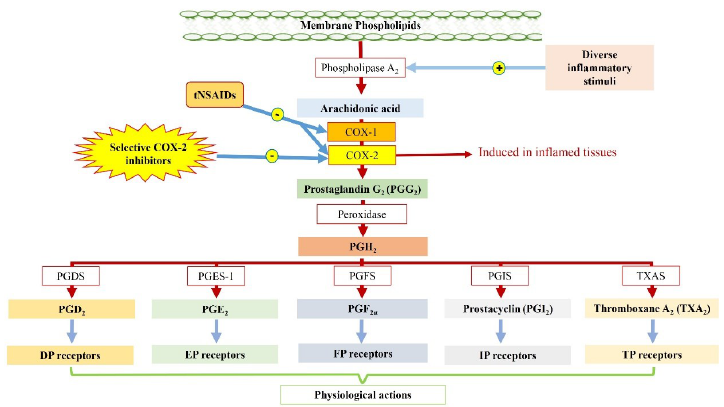
Figure 1. Biosynthesis of prostaglandins and associated compounds. For instance, arachidonic acid is liberated by Ca 2+ stimulation mediated by diverse inflammatory stimuli or phosphorylation of phospholipase A 2 from the membrane phospholipid. The cyclooxygenase enzymes (both COX-1 and COX-2) epoxygenate arachidonic acid into prostaglandin G2 (PGG 2 ), which is further converted into prostaglandin H 2 (PGH 2 ) with the help of peroxidase enzyme. Following this, PGH 2 undergoes conversion into prostaglandin (PG) analogues (i.e., PGD 2 , PGE 2 , PGF 2 α , and PGI 2 or prostacyclin) and thromboxane A 2 (TxA 2 ) by the help of isomerases and synthases, respectively. The formed PGs and associated compounds are capable of triggering a myriad of signalling events by activating their respective membrane receptors located at the site of production. The traditional non-steroidal anti-inflammatory drugs (tNSAIDs) inhibit cyclooxygenase enzyme non-selectively and prevent prostaglandin synthesis, whereas selective COX-2 inhibitors (coxibs) inhibit the COX-2 isoform that is induced by inflammation. PGDS: prostaglandin D synthase, PGES-1: prostaglandin E synthase-1, PGFS: prostaglandin F 2 α synthase, PGIS: prostacyclin synthase, and TXAS: thromboxane A 2